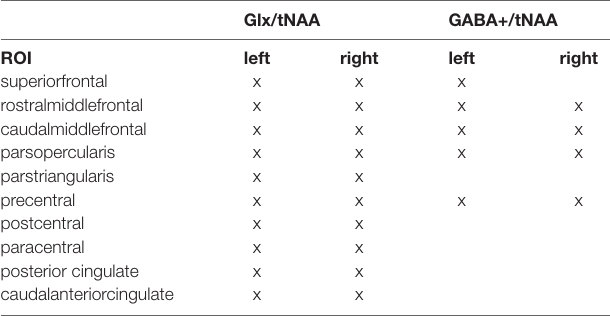
TABLE 1 | ROIs of each hemisphere included in the analysis of Glx/tNAA and GABA+/tNAA ratios. ROI left right left right